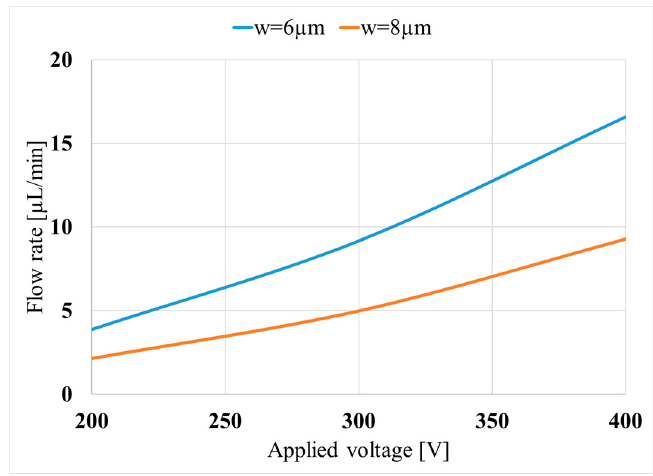
Figure 12. Variation of the obtained flow rate with the applied voltage ( L p ) for two valve widths ( w ); ( L p = 5 mm and h p = 130 μ m).